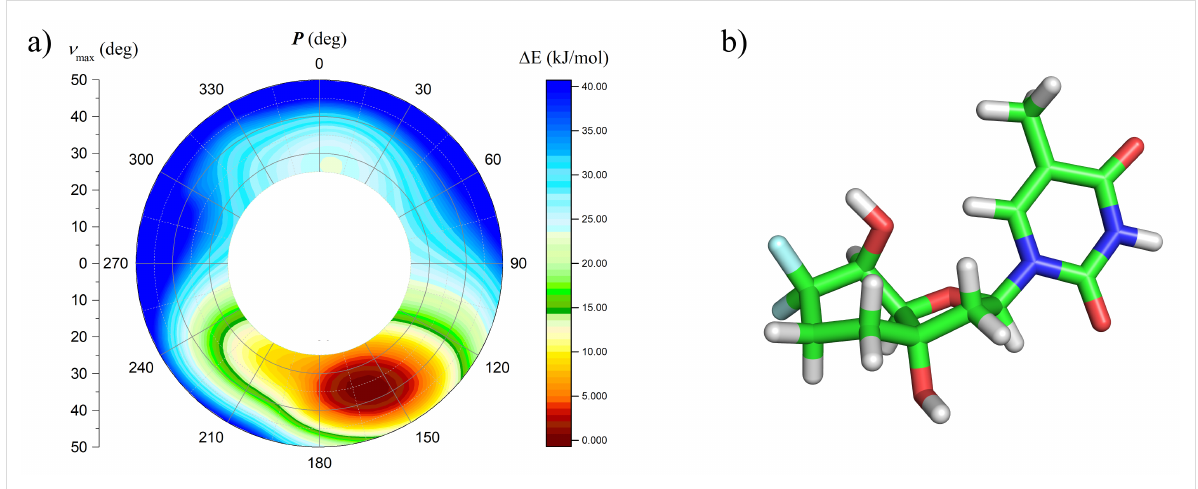
Figure 3: a) Potential energy profile versus pseudorotation phase angle of nucleoside 7 and b) its minimal energy